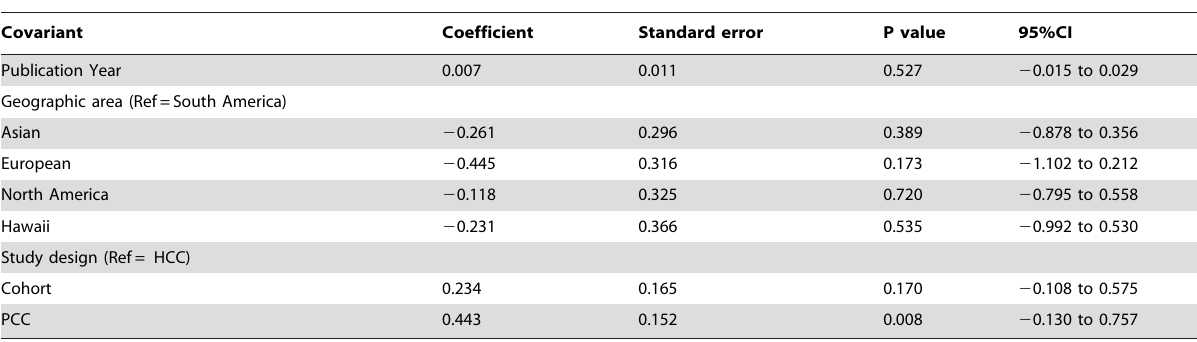
Table 4. Meta-regression